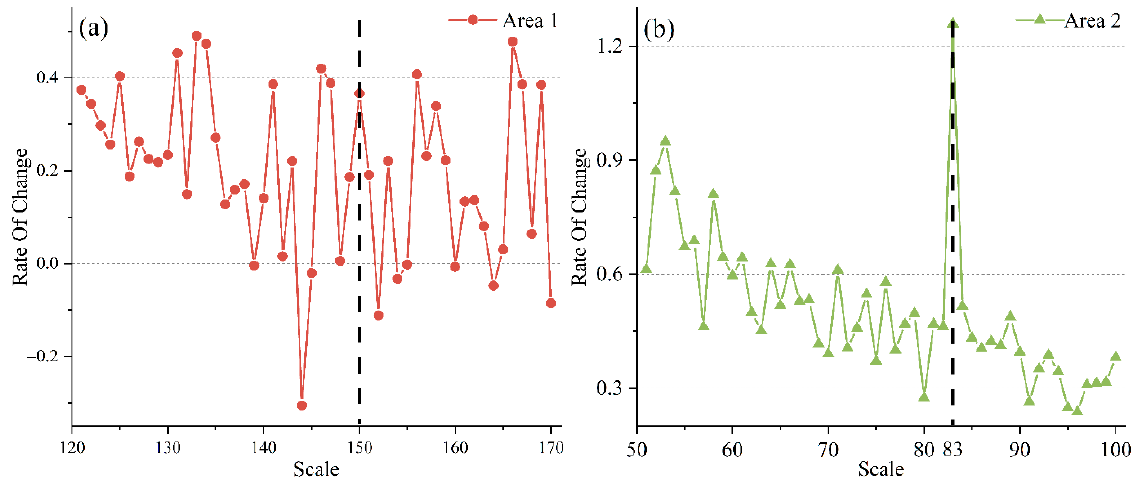
Figure 4. The results of the estimation of scale parameter (ESP) tool in Area 1 ( a ) and Area 2 ( b ). The black vertical dashed lines indicate the selected scale parameters of Area 1 and Area 2.